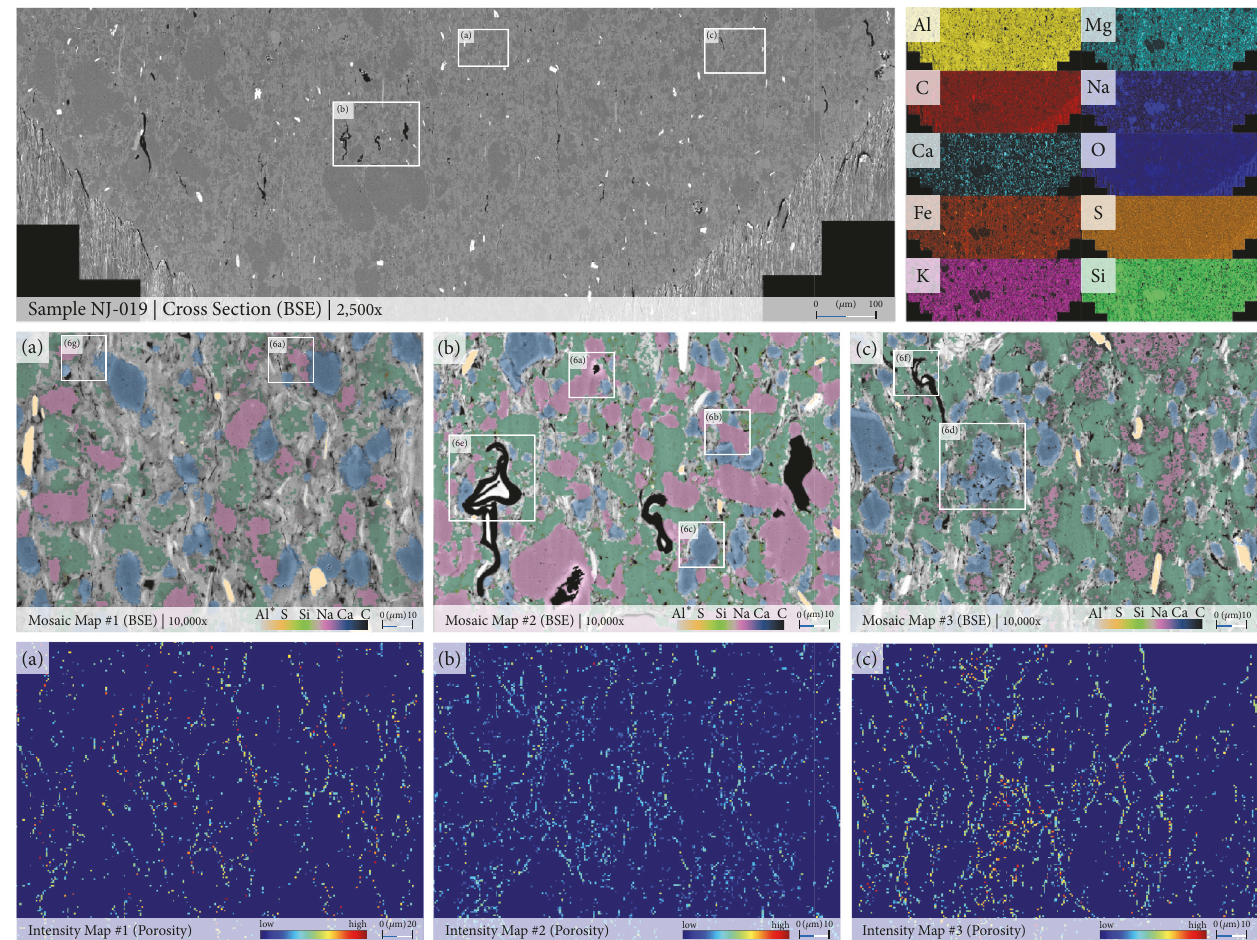
Figure 4: BIB-SEM investigation of sample NJ-019 including their local porosity maps and selected areas of interest depicted in Figure 6. Pyrites (corresponding to the element S) appear in a bright yellow; silicates (corresponding to Si) are colored green (in this sample assumed to represent K-containing feldspar grains); Na-feldspars (corresponding to Na) are colored pink; carbonates (corresponding to Ca) are colored blue; OM (corresponding to C) is colored